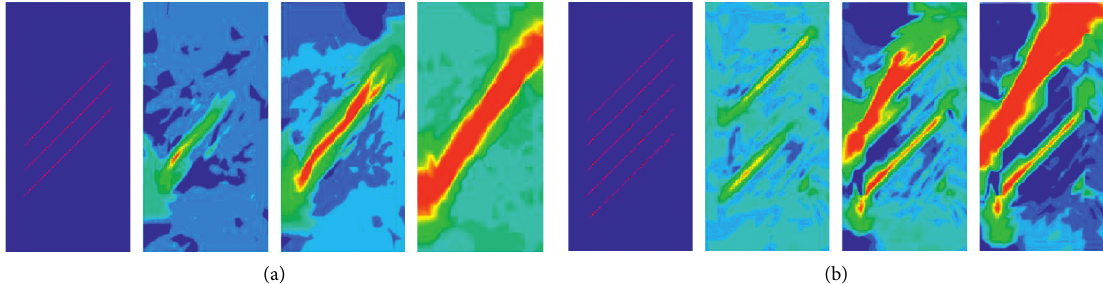
Figure 14: Numerically simulated crack evolution in specimens containing multiple parallel cracks.